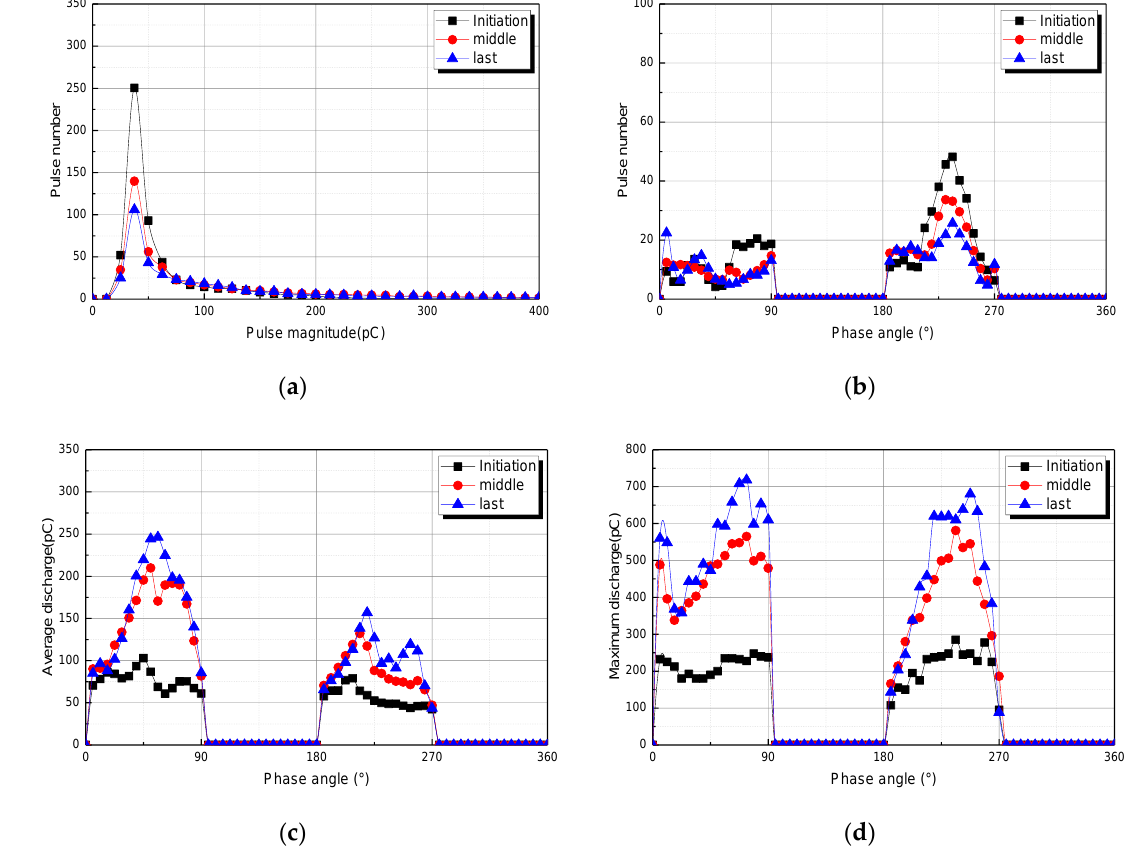
Figure 4. Statistical distributions of PD for tree model 1: ( a ) Hn(q) distribution; ( b ) Hn(Φ) distribution; ( c ) Hq n (Φ) distribution; ( d ) Hq max (Φ) distribution.